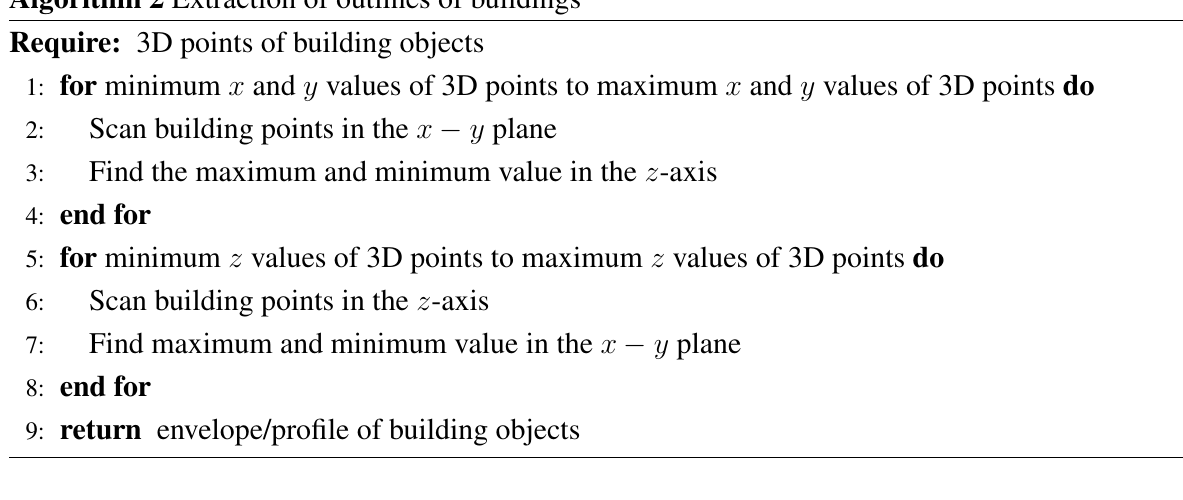
Figure 9. In red and blue, the building outline obtained from the first passage. In green and black, the outline obtained from the second passage. Only the top half of the two outlines in blue and black, respectively, is subjected to Iterative Closest Point